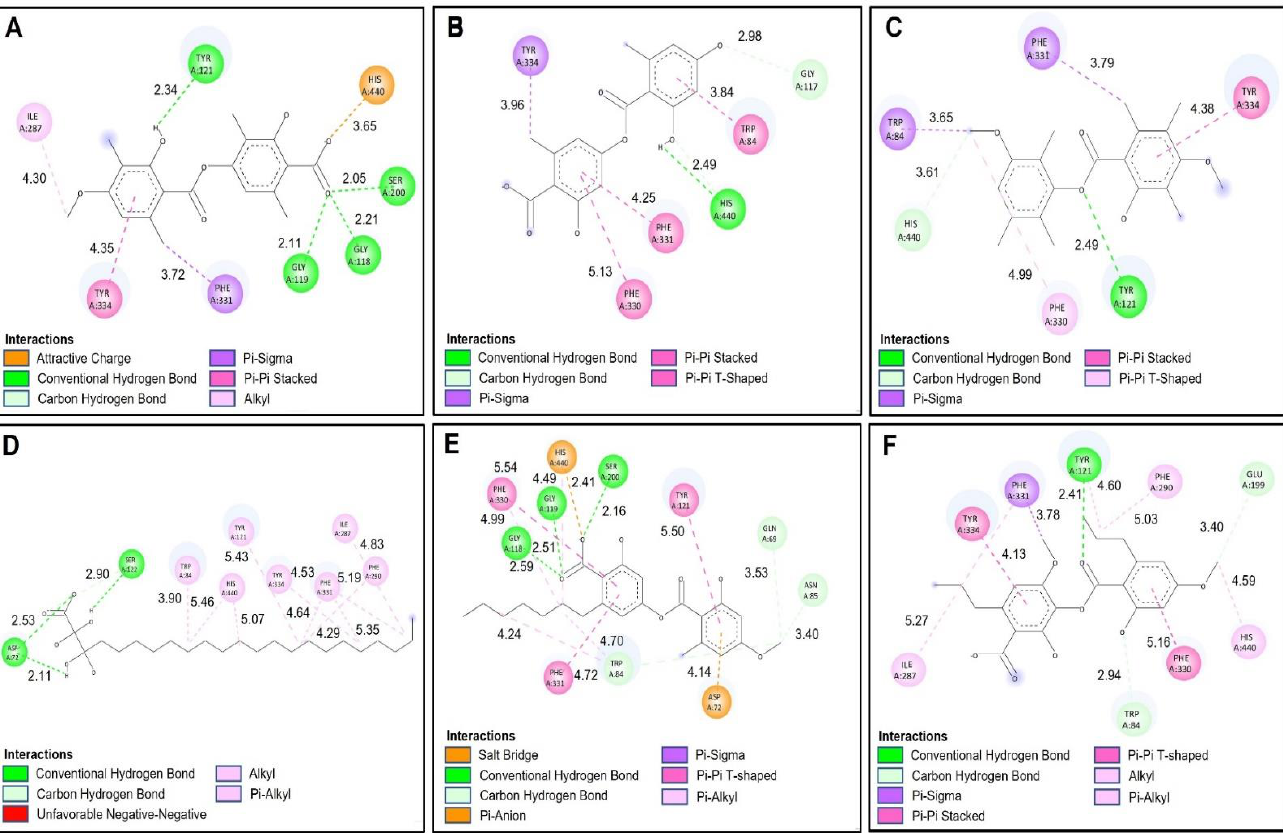
Figure 4. Two-dimensional diagram of compounds from Lecania brialmontii , Pseudephebe pubescens and Sphaerophorus globosus extracts and residues of the Torpedo californica acetylcholinesterase (TcAChE) catalytic site; ( A ) Barbatic acid at the catalytic site; ( B ) Lecanoric acid at the catalytic site; ( C ) Brialmontin 2 at the catalytic site; ( D ) Tetrahydroxytricosanoic acid at the catalytic site; ( E ) Sphaerophorin at the catalytic site; ( F ) Sekikaic acid at the catalytic site. Yellow dotted lines indicate hydrogen bond interactions; cyan dotted lines represent π - π interactions; magenta dotted lines represent T-shape; and red dotted lines indicate salt bridge interactions.